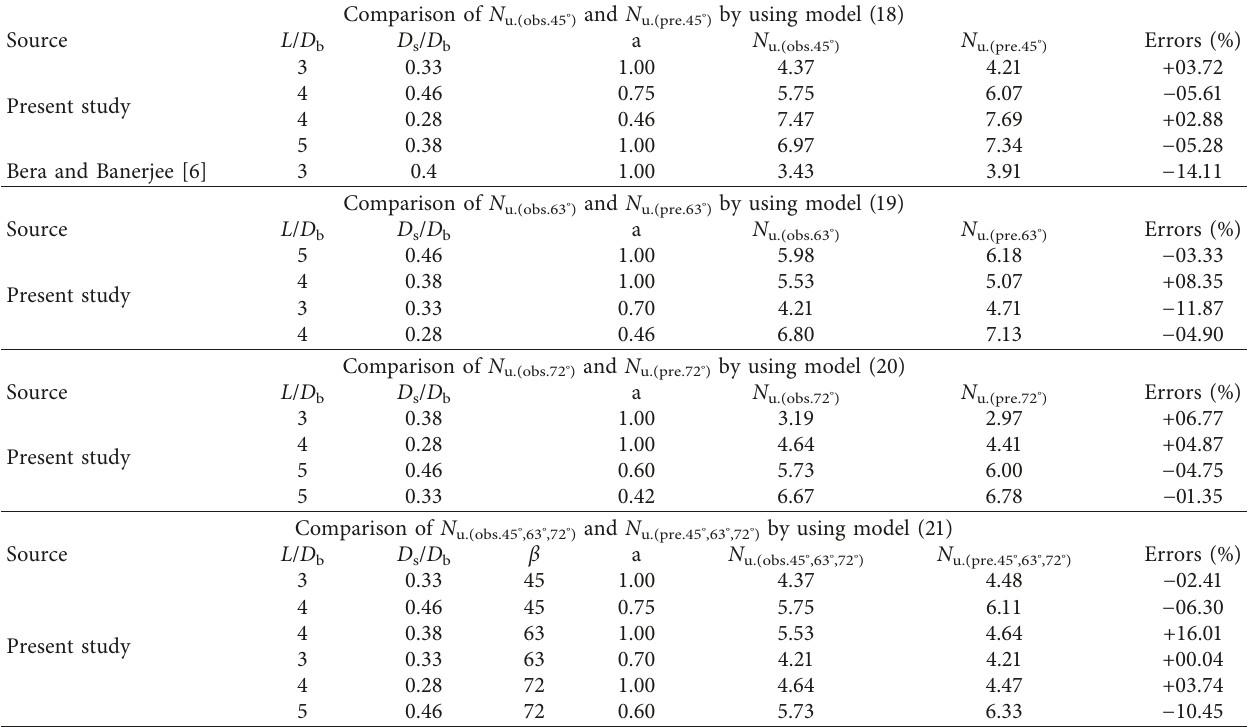
Table 6: Comparison of the observed breakout factor and predicted breakout factor by using models (18) to